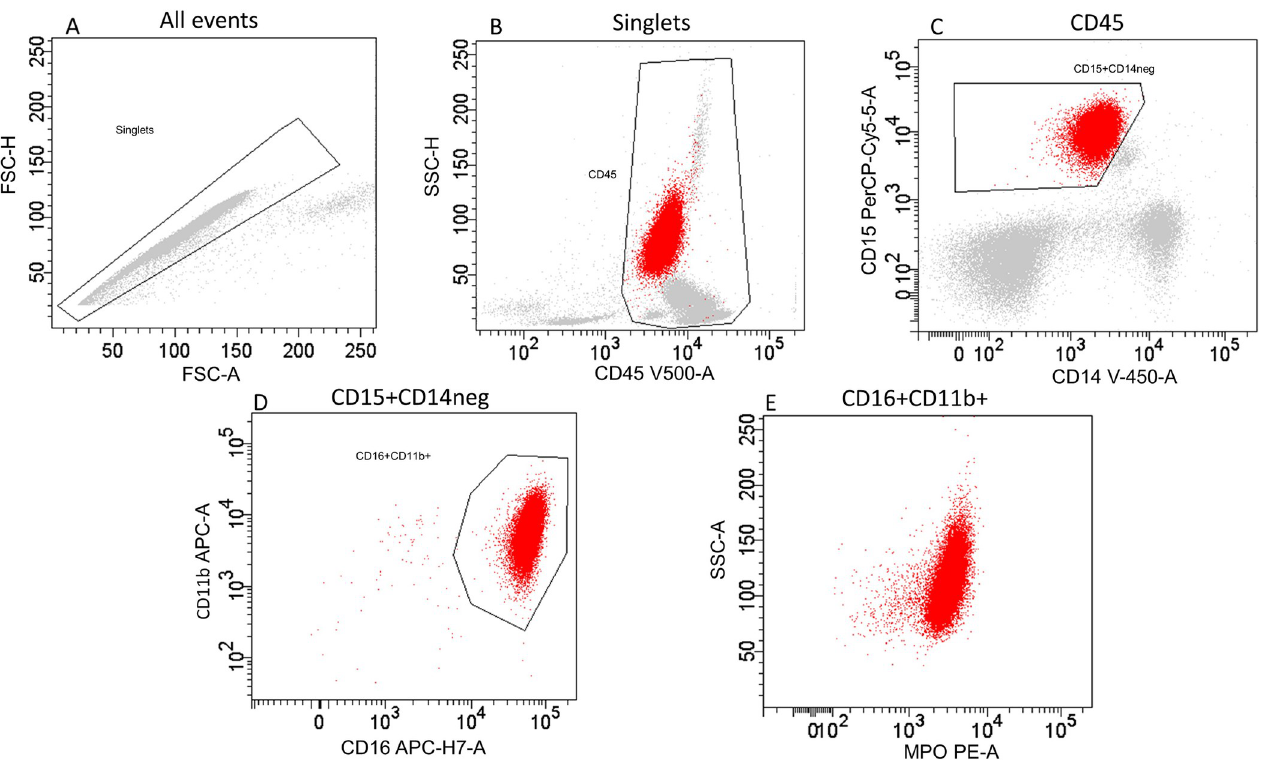
Fig 2. Simplified flow cytometric gating strategy for quantifying peripheral blood neutrophil myeloperoxidase expression. CD45+ cells were first individualized by crossing the singlet gate (A) and CD45 positive gate (B). Population of granulocytes (CD15+ CD14-) was identified (C). Gated cells were selected based on CD16/CD11b double positivity (D) The MPO SSC dot plot (E) was used only to visualize MPO expression of mature neutrophils. The cell population identified was MPO mature neutrophils (red dots). Abbreviations: CD = cluster of differentiation; FSC-A = forward scatter area; FSC-H = forward scatter height; MPO = myeloperoxidase; RCV = robust coefficient of variation; SSC-A = side scatter area; SSC-H = side scatter height.